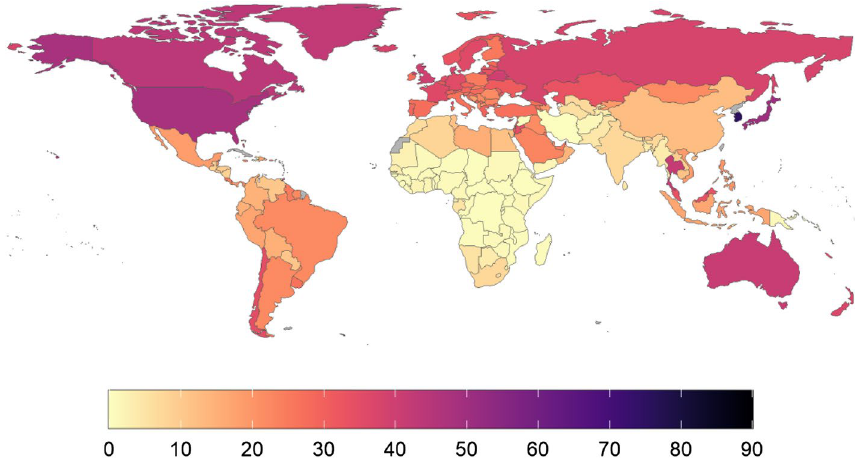
Figure 5. Heatmap of hours of yearly playtime per capita (HPC), Oct 2020–2021. Countries/regions with no data in grey colour. This map was generated using ggplot in R (v4.0.2). Code for reproducing these maps is available at the OSF repository associated with the project.